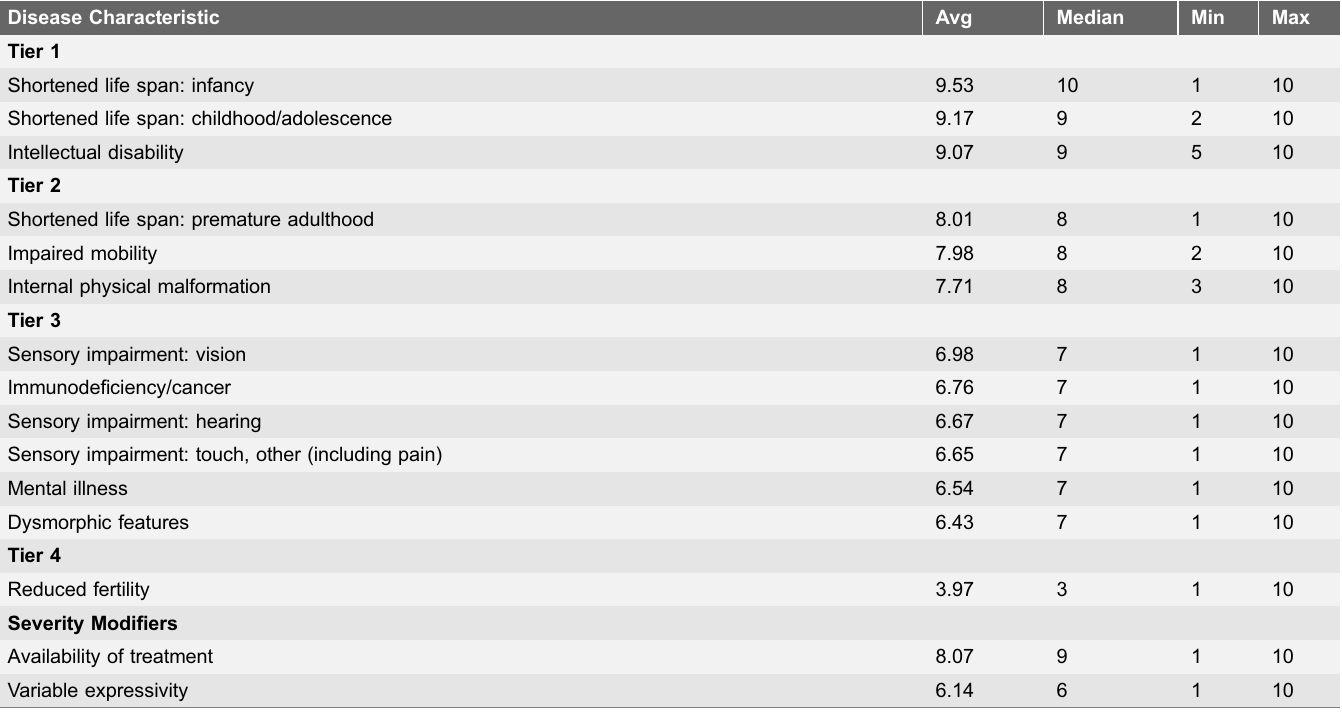
Table 1. Ratings of disease